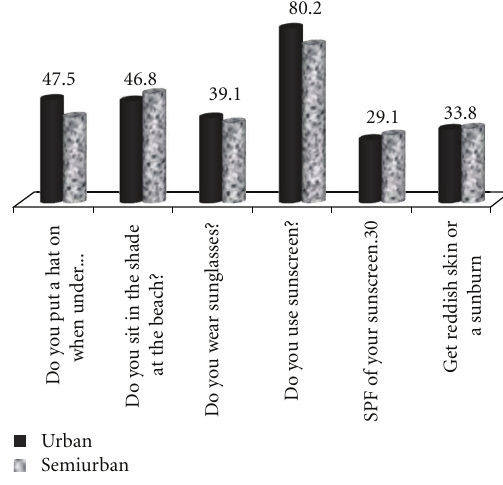
Figure 1: Students’ behaviour according to living area.